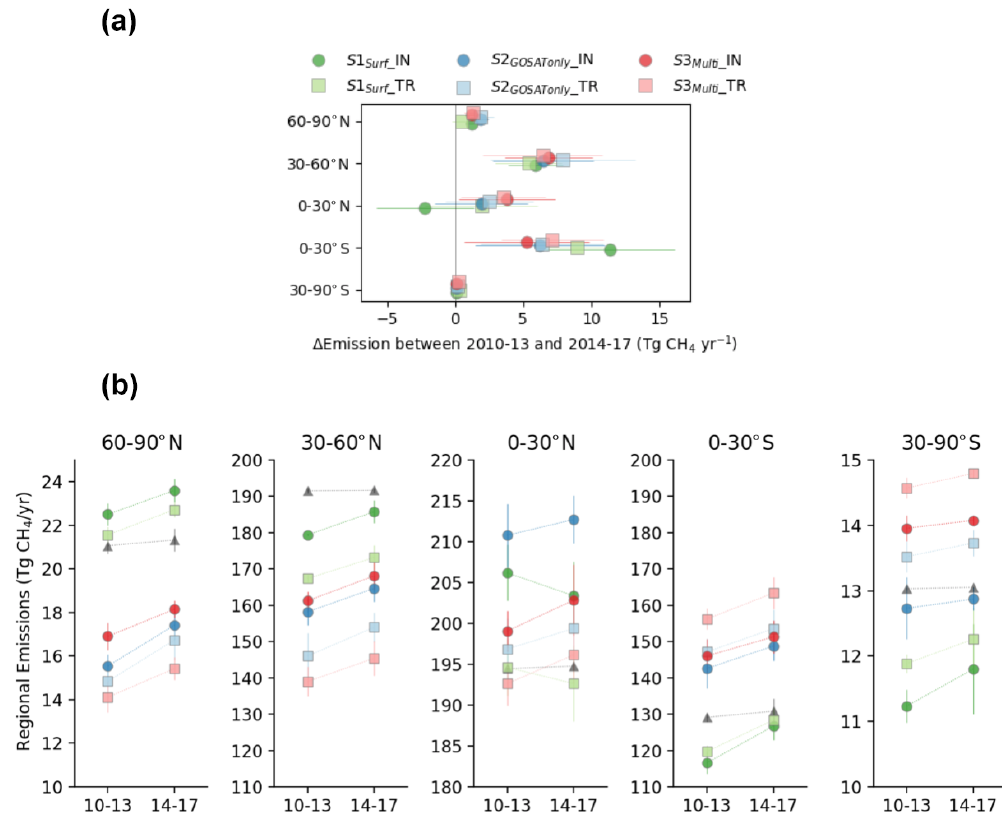
Figure 4. (a) Emission change between 2010–2013 and 2014–2017 in the five latitudinal zones. The error bars represent the standard deviation of changes in CH 4 fluxes between the two periods. (b) Zonal fluxes estimated by different versions for the period 2010–2013 and 2014–2017. The mean values for each 4-year period are shown and errors bars represent their 1 σ standard